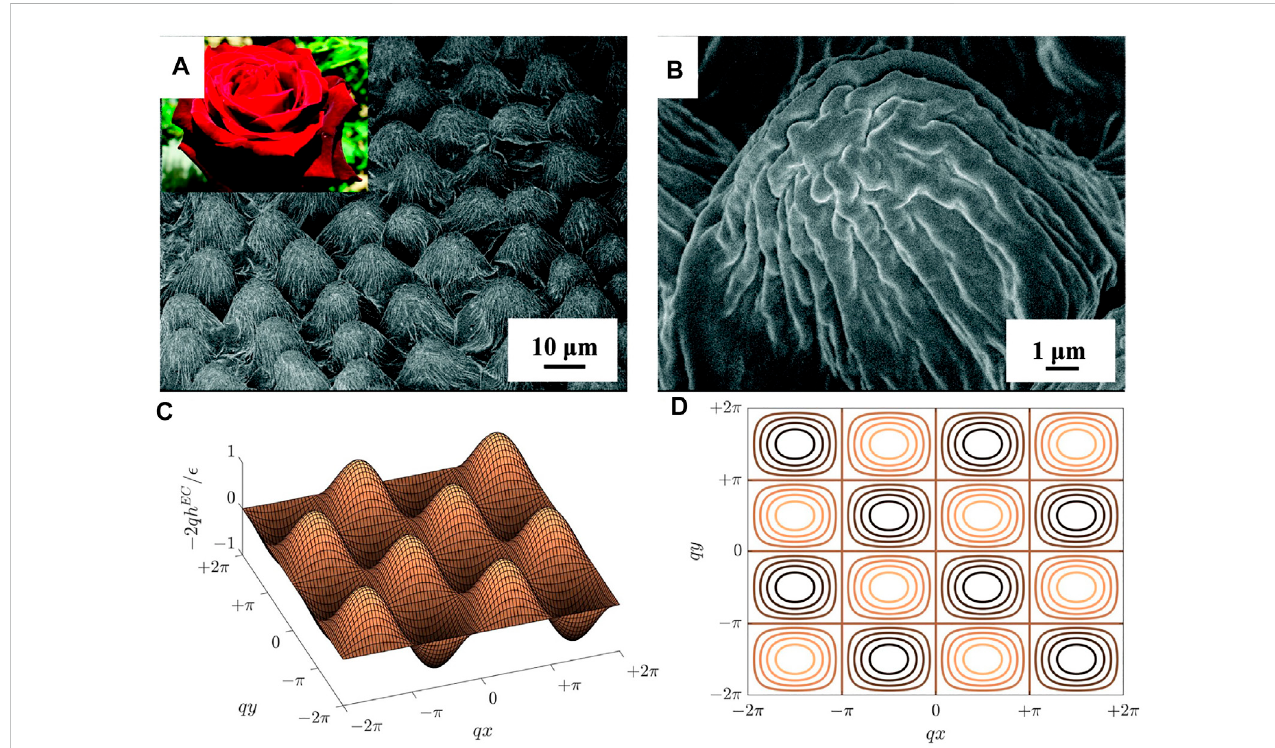
FIGURE 8 (A) and (B) SEMimagesofthesurfaceofrosepetalsurface. (C) Theeggcartonwrinklingpro fi lefrompureanchoringmodelsolvedin2D. (D) Thetopview of (C) . (A) and (B) arereprintedwithpermissionfrom(Fengetal.,2008).Copyright ⓒ 2008AmericanChemicalSociety. (C) and (D) arereprintedfrom(WangZ. et al., 2021), Copyright (2021), with permission from